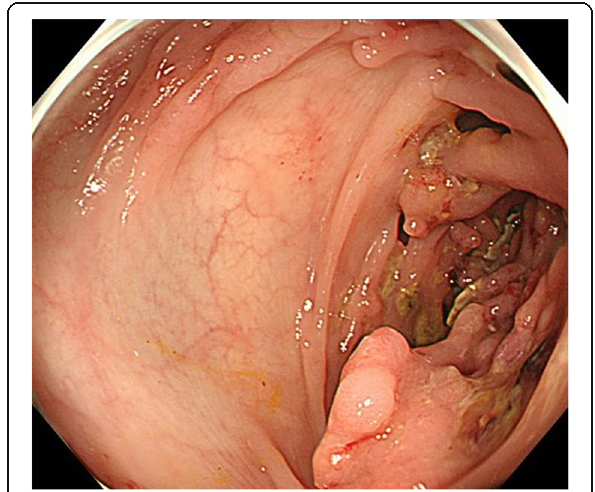
Fig. 1 Colonoscopic study of the tumor. Colonoscopy revealed a large tumor with numerous white-pale reddish polyps of worm-like shape in the sigmoid colon. Biopsies showed well-differentiated to moderately differentiated tubular adenocarcinoma. The colonoscope could not be inserted beyond this point